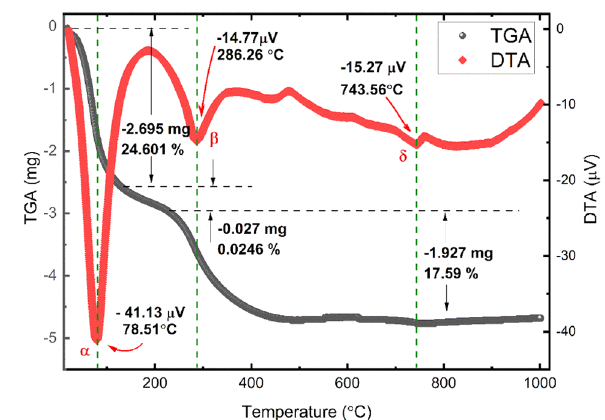
Fig. 2 XRD patterns of individual binary oxides ( a ) MgO, ( b ) CoO, ( c ) NiO, ( d ) CuO, and ( e ) ZnO